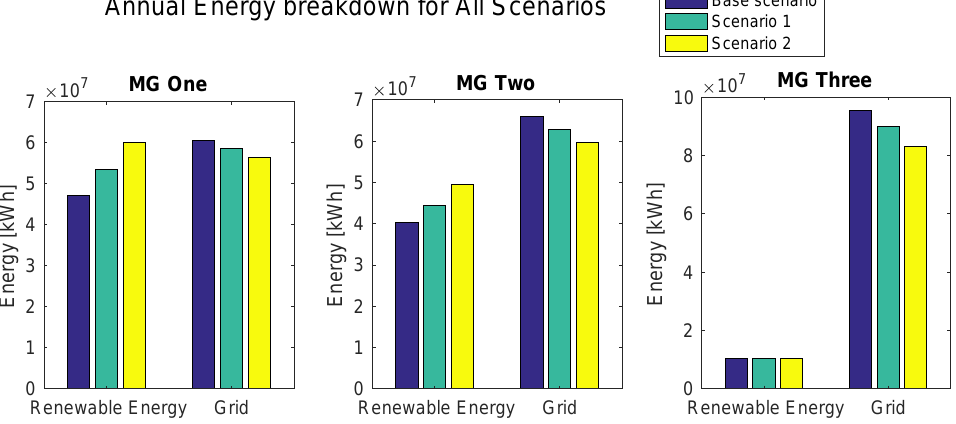
Figure 8. Annual energy breakdown for each